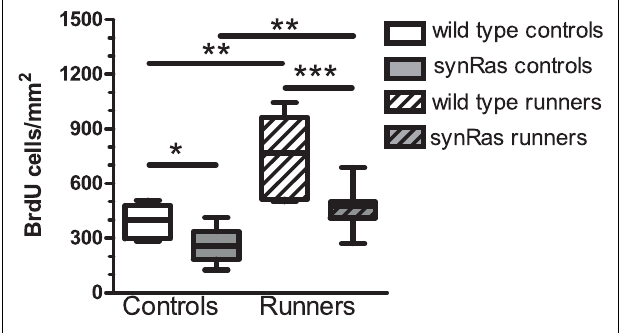
FIGURE 1 | Quantifi cation of the number of bromodeoxyuridine-labeled cells per mm 2 in the four different groups: wild type controls ( n = 6), synRas controls ( n = 8), wild type runners ( n = 11), synRas runners ( n = 13).